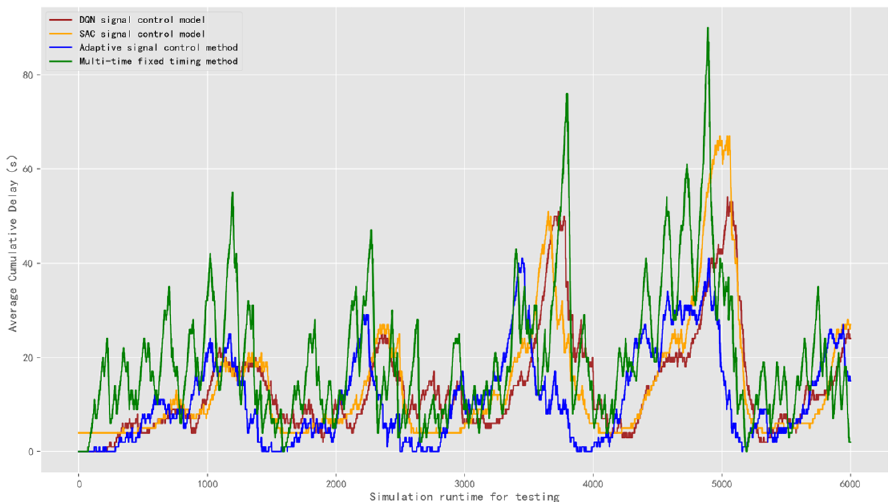
Figure 13. Comparison of the average cumulative delay of signal control methods under test traffic scenario 1.